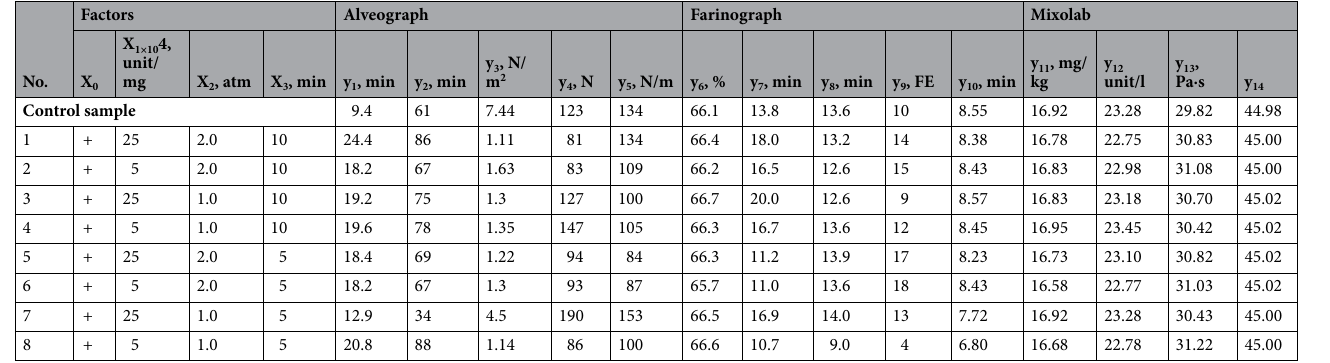
Table 3. Rheological properties of dough made from whole-ground class 3 wheat flour with ion-ozone cavitation treatment.